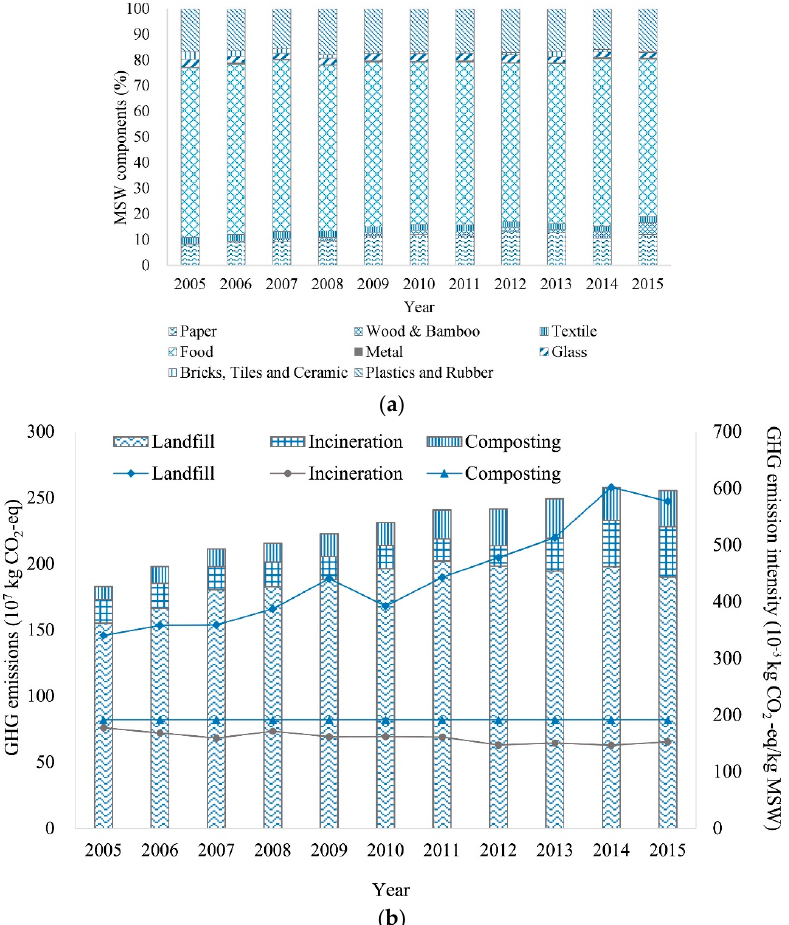
Figure 6. ( a ) Compositions of MSW (municipal solid waste) components in Shanghai (2005–2015); ( b ) GHG emissions and the intensity of three MSW disposal methods (2005–2015). The left axis used for the bar graph represents the GHG emissions, and the right axis used for the broken line graph represents the GHG emission intensity, reprinted with permission from Ref. [38].